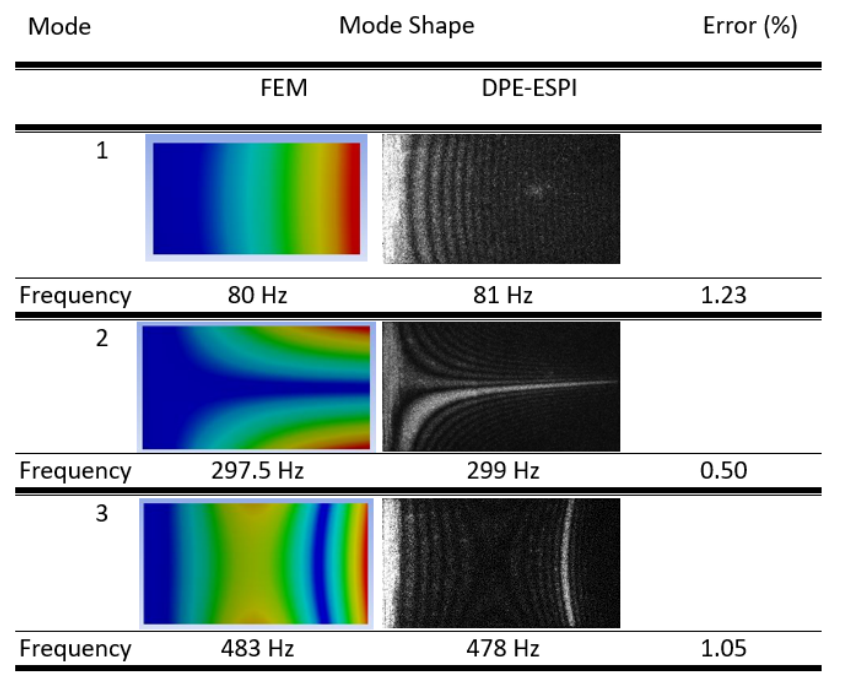
Figure 7. Dimensions and construction of bluff splitter body and PVEH plate.